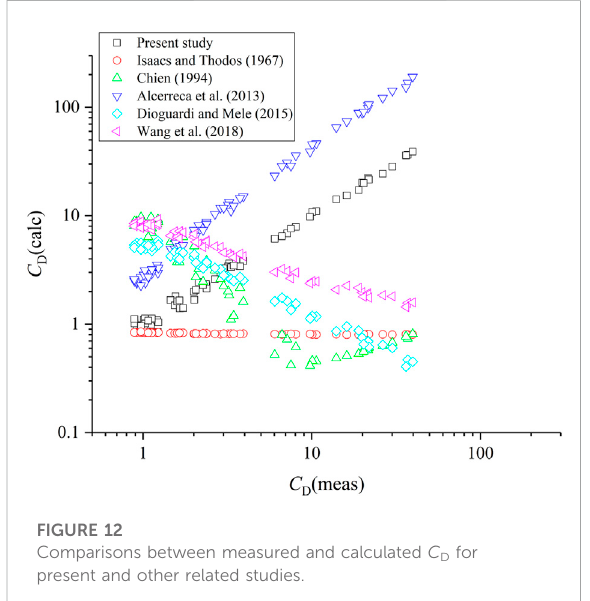
FIGURE 13 The relationship between C D, sph and R ep for smooth sphere, the top right-hand corner indicates the best- fi t curve with 10 < < R ep